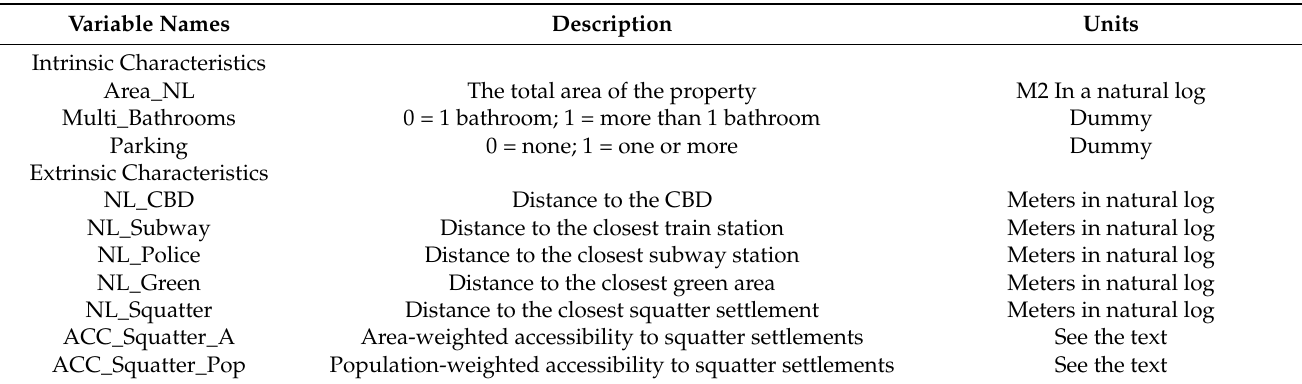
Table 4. Definitions of the explanatory